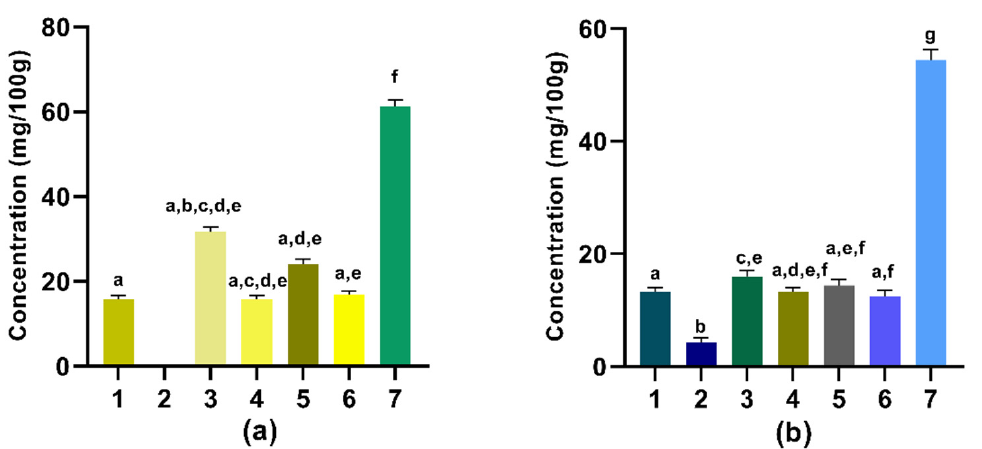
Figure 6. Levels of linoleic and linolenic acids found in the edible plant organs from Solanum nigrescens ( 1 ), Sechium edule ( 2 ), Rumex obtusifolius ( 3 ), Amaranthus hybridus ( 4 ), Piper auritum ( 5 ), Rhamnus pompana ( 6 ), and Yucca aloifolia ( 7 ). The contents of linoleic acid ( a ) and linolenic acid ( b ) are shown. Different letters indicate means ( n = 15) with statistically significant differences by ANOVA–Tukey’s test at p < 0.05. Detailed information can be found in Table S5.